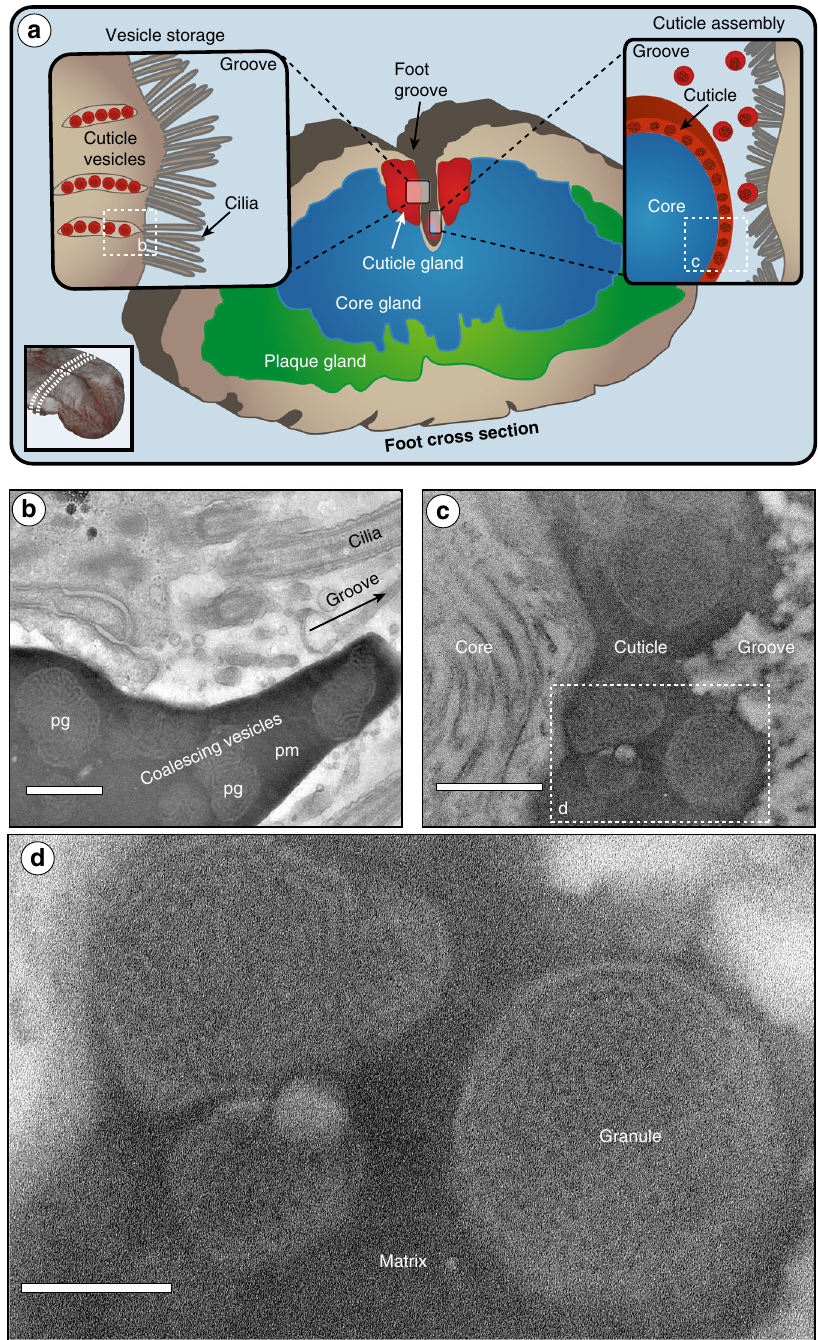
Fig. 3 Cuticle formation in the mussel foot groove via coalescence of cuticle secretory vesicle contents. a Schematic overview of transverse section of mussel foot tissue showing anatomy of byssal glands. Cuticle secretory vesicles (in red) are lined up at the edge of the cuticle gland, ready to be secreted into the groove, aided by cilia. During cuticle assembly, the secretory vesicle contents cluster and coalesce into the groove spreading over the formed core surface. b TEM image from a stained section of an induced foot in the region indicated in a , showing coalesced cuticle secretory vesicles about to be released into the groove. Notably, the proto-matrix (pm) of several vesicles merges to form a continuous matrix, while the proto-granules (pg) retain their brain-like structure. Scale bar = 500 nm. c TEM image from stained section of an induced foot in the region indicated in a , showing a formed induced thread with intact cuticle. Scale bar = 500 nm. d Magni fi ed region from c showing details of the induced cuticle including granule and matrix. Scale bar = 200